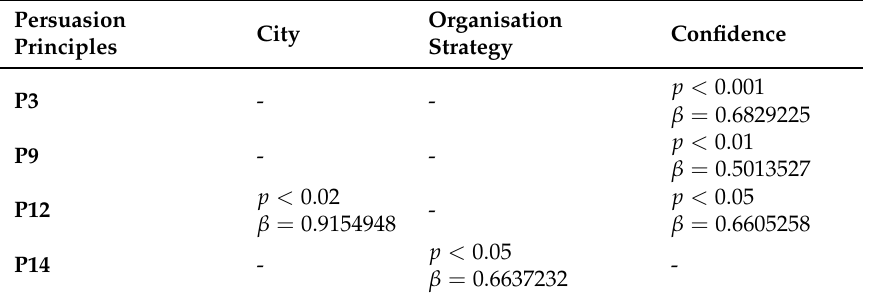
Table 8. Significant p -values (and the associated power) that ascertain the dependencies between Factors and Persuasive Principles for the POST survey.